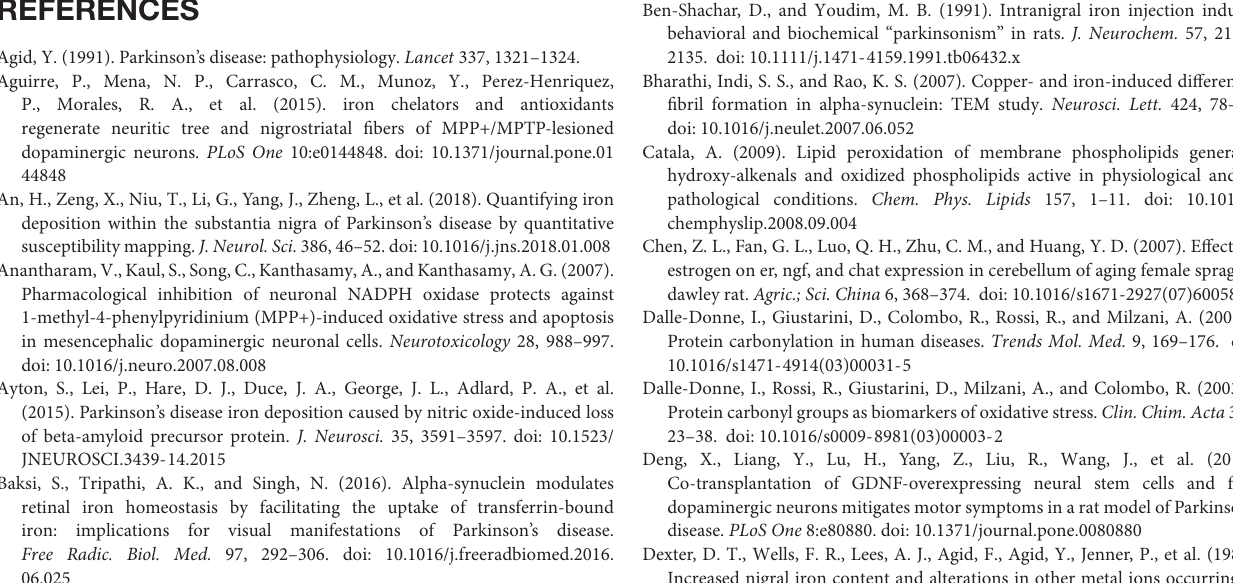
FIGURE S1 | Semi-diagrammatic illustrations of the SN of macaque monkey brain in stereotaxic coordinates from frontal planes A15.2-A8.4. The nucleus of the nigra was labeled with red circle. SNc, substantia nigra pars compact; SNd, substantia nigra, pars diffusa; St, nucleus